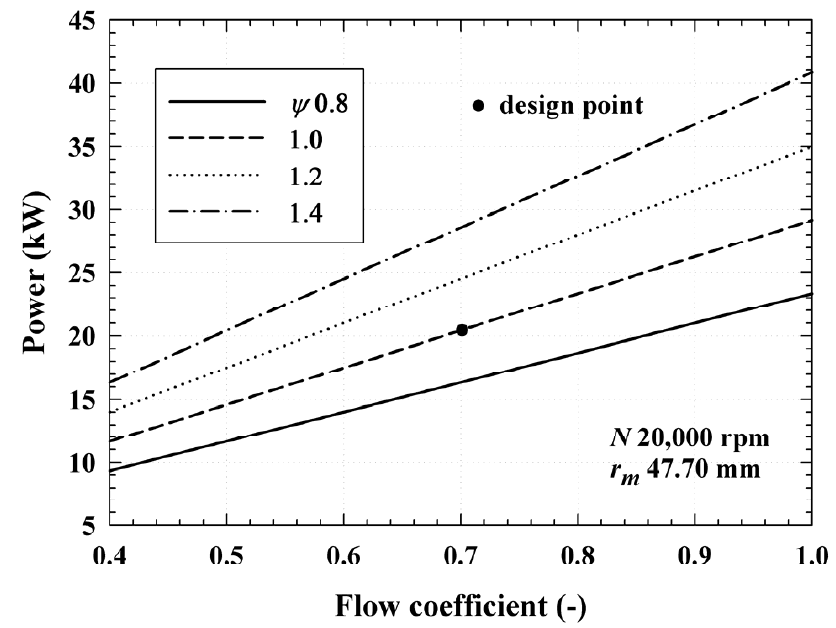
. W t ) when the flow coefficient ( ϕ ) ranges from 0.4 to 1.0 and loading Figure 9. Power of the turbine ( Figure 9. Power of the turbine ( 𝑊(cid:4662) ) when the flow coefficient ( 𝜑 ) ranges from 0.4 to 1.0 and loading (cid:3047) coefficient ( ψ ) ranges from 0.8 to coefficient ( 𝜓 ) ranges from 0.8 to 1.4.